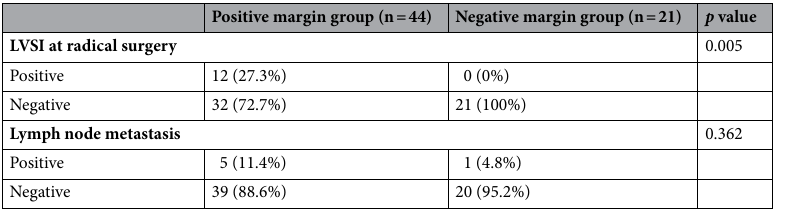
Table 3. The association between a positive margin at conization and metastatic potential in stage IB1 squamous cell carcinoma. LVSI lymphovascular space invasion. p value of < 0.05 was considered statistically significant.